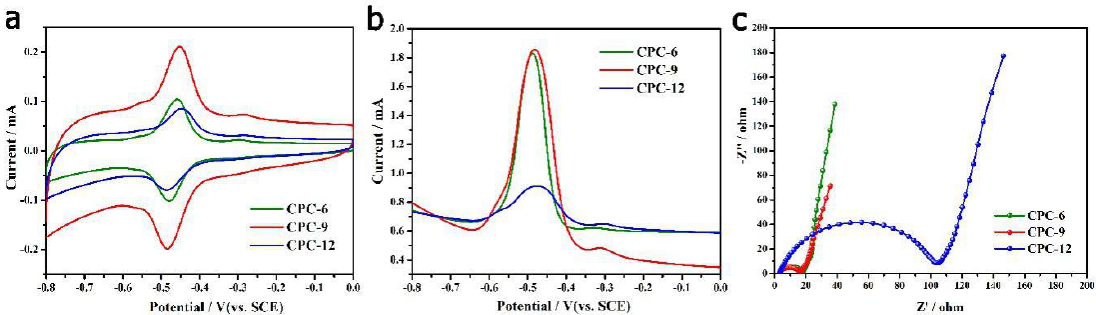
Figure 4. CVs ( a ), DPVs ( b ) and Nyquist plots ( c ) of different electrodes in 0.1 M PBS buffer with 2 µ M μM FMN. 2